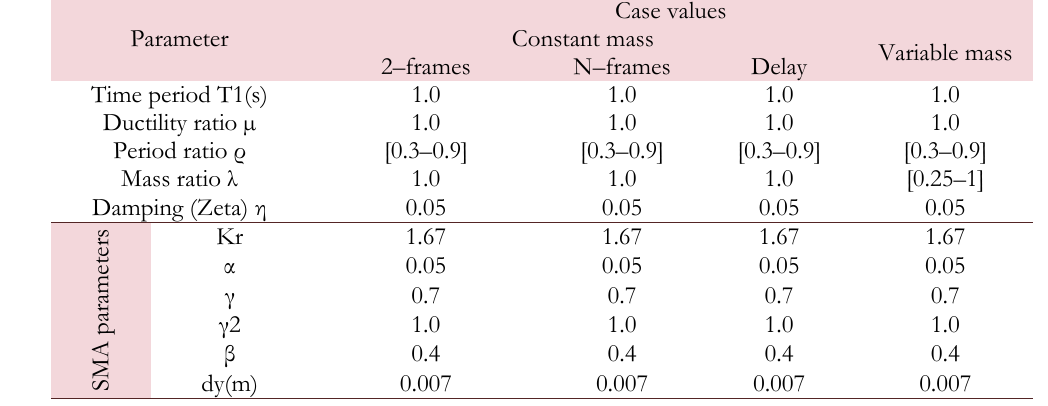
Table 1. Parameter values of the bridge and the SMA used in the study for all